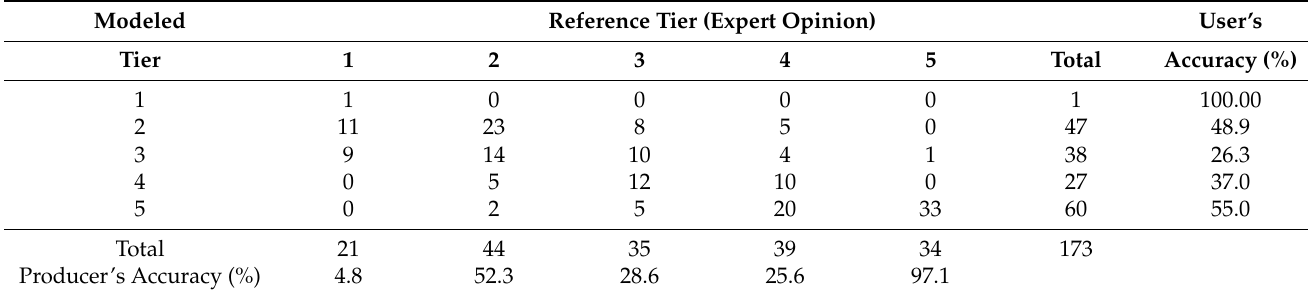
Table 2. Omission–commission matrix for validating the ecological condition class modeling effort based on the parameters used in Table 1.